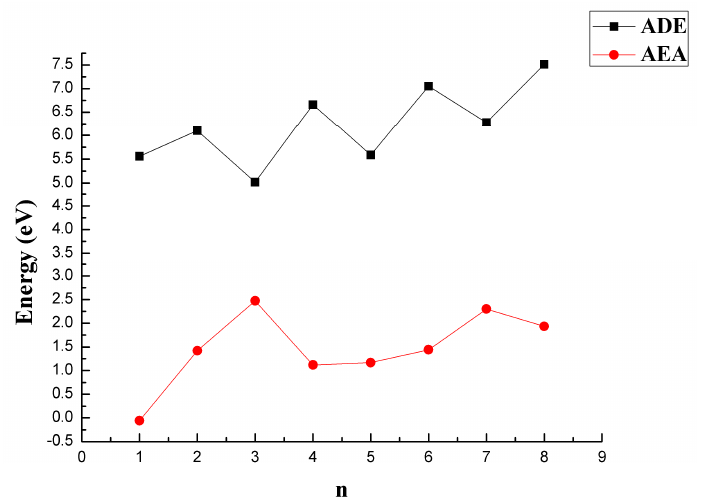
Figure 10. ADE and AEA of the most stable structures of CaB n (n = 1–8) clusters at the MP2/6- 311+G(d)//B3LYP/6-311+G(d)